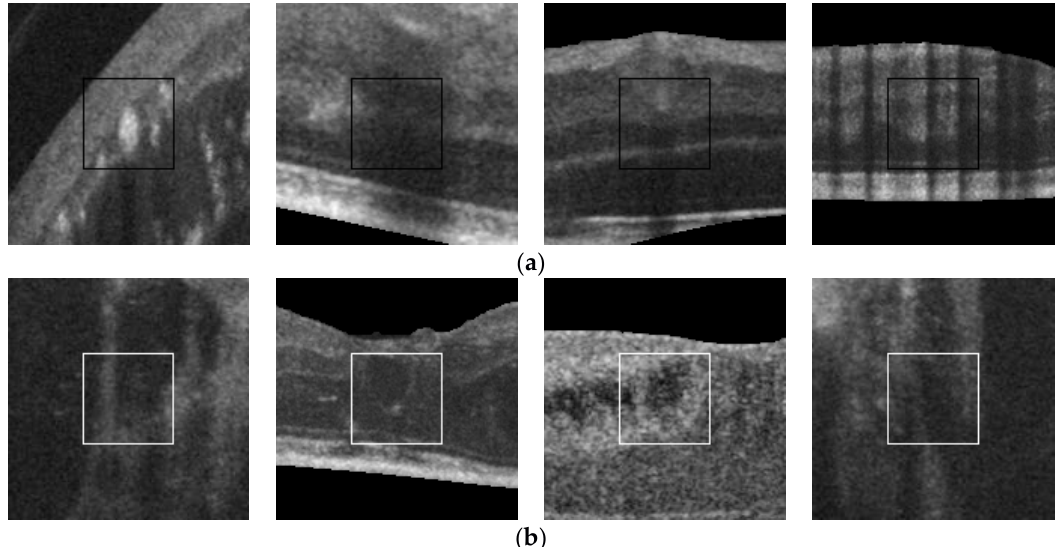
Figure 1. Results obtained with different levels of complexity. ( a ) Non-cystoid regions; ( b ) Cystoid